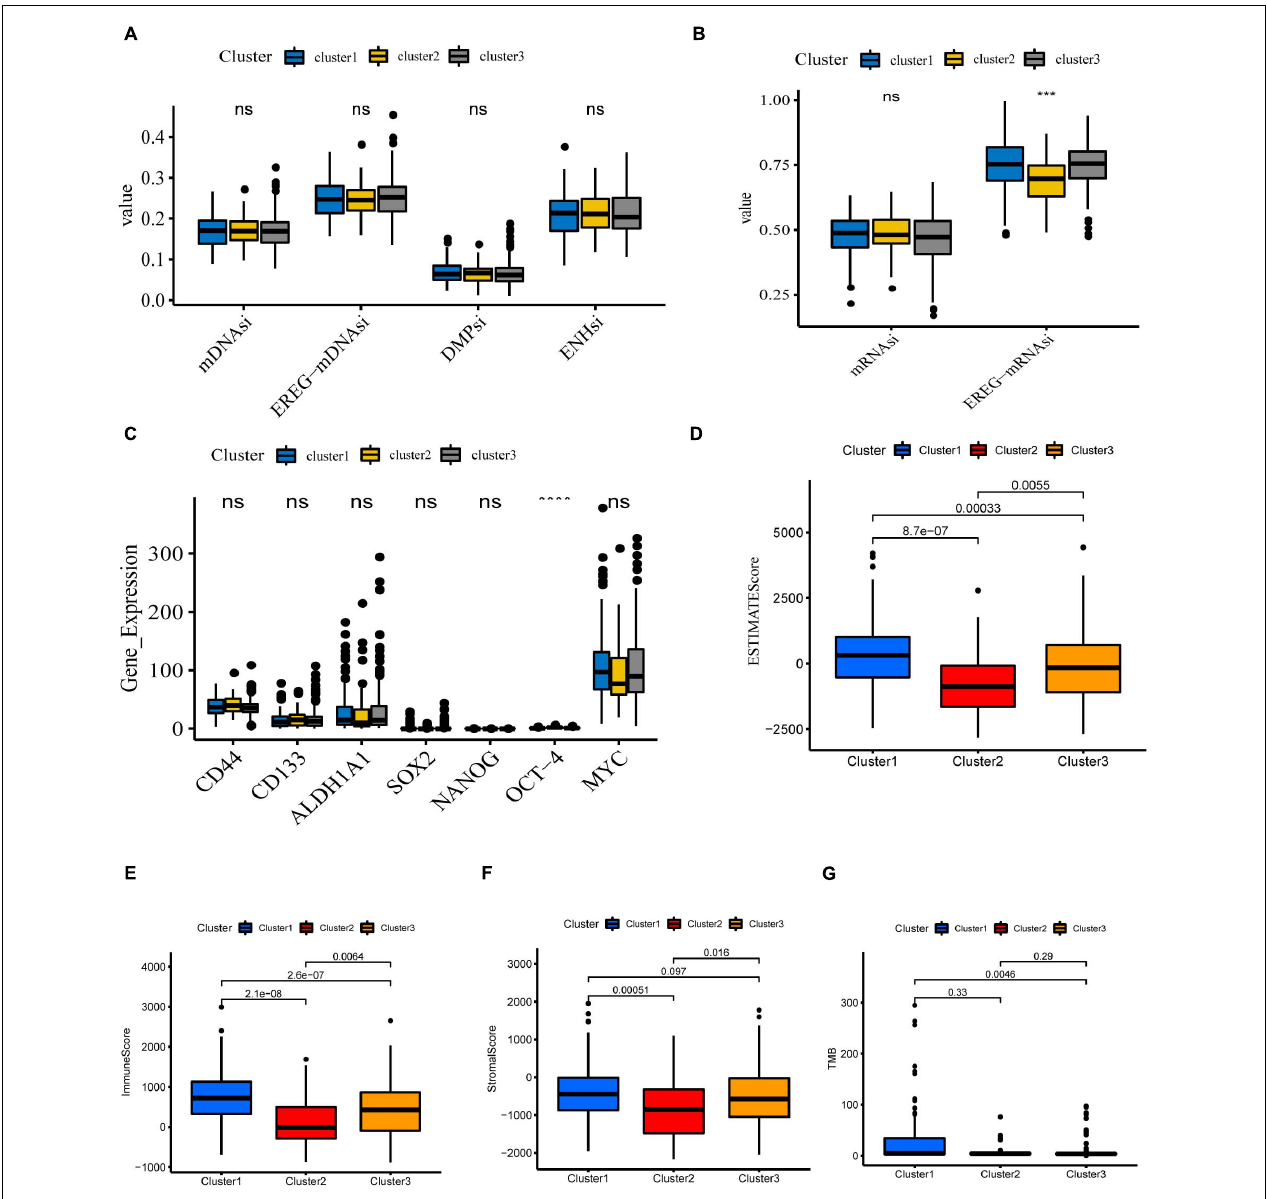
FIGURE 5 | Potential biological functions of the three clusters. (A,B) Differential expression of stemness indices among three clusters, including mRNAsi (based on gene expression) and mDNAsi (DNA methylation-based stemness index) in the TCGA-COAD cohort. (C) Differential expression of relevant stem cell markers in COAD among three clusters. (D–G) Different expression of ESTIMATEscore, Immunescore, Stromalscore, TMB in three clusters (**** P < 0.0001; *** P <